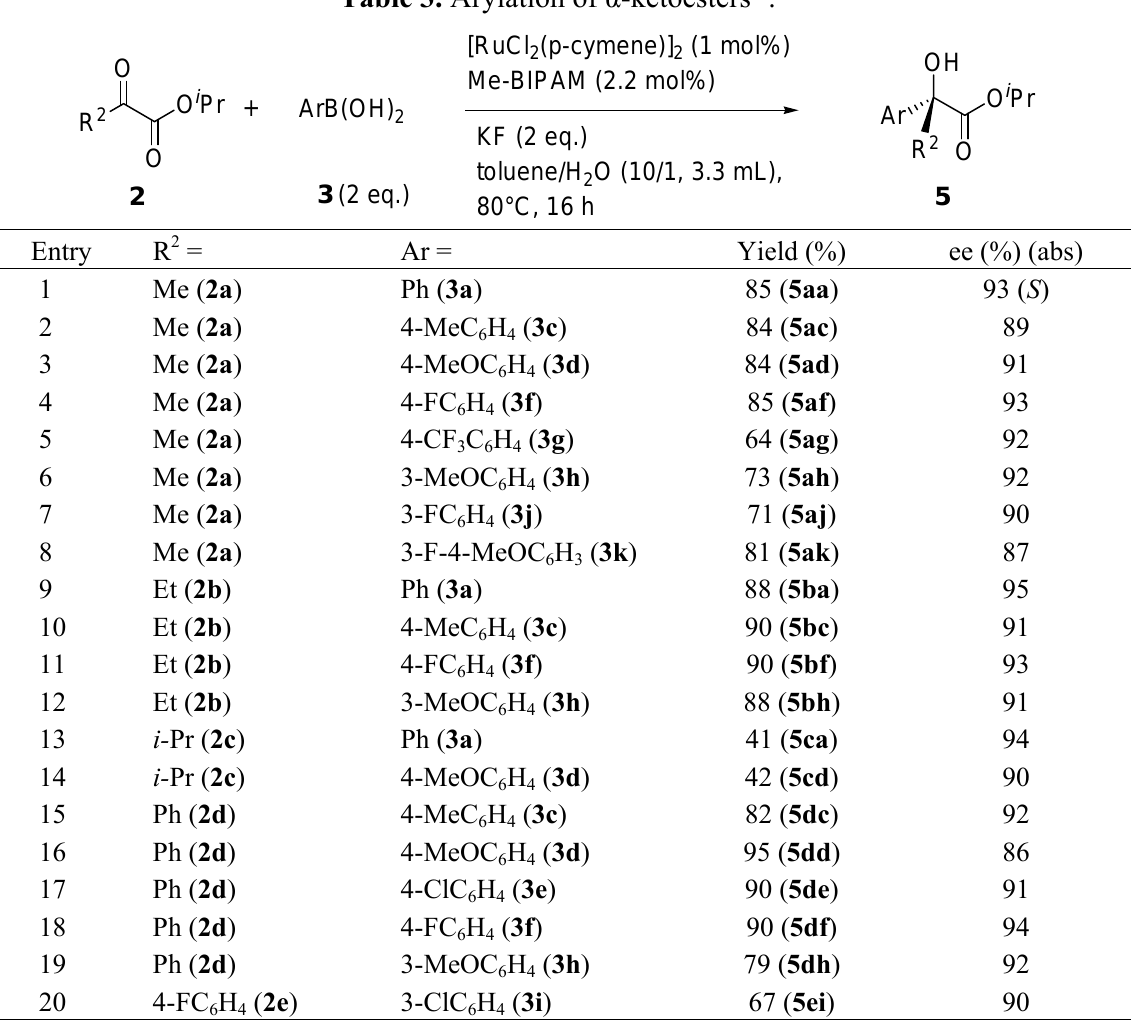
Table 3. Arylation of α -ketoesters a